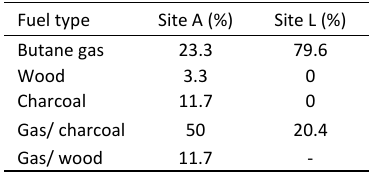
Table 3. Type of cooking energy used at the two surveys sites